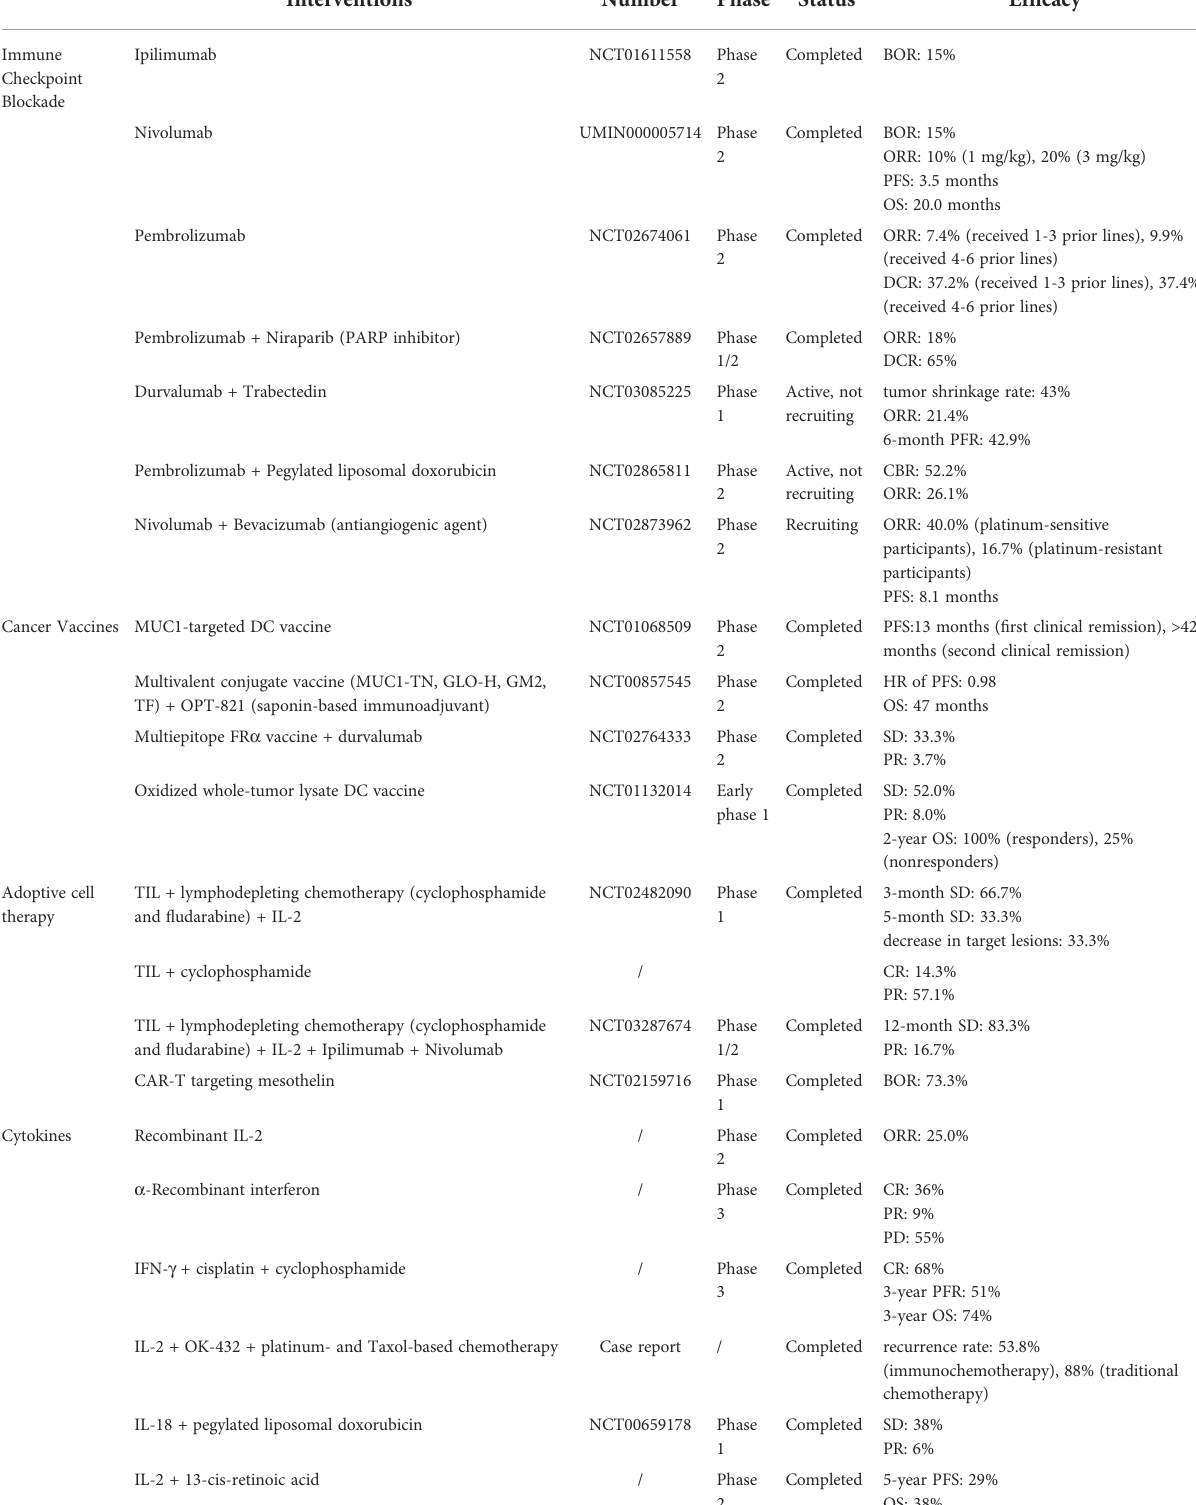
TABLE 1 Clinical trials of immunotherapy for ovarian